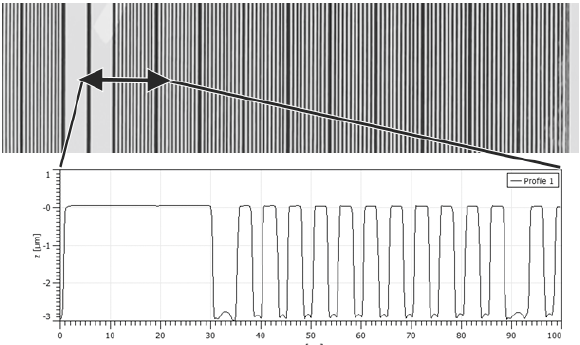
Figure 11. Tip-testing standard TPN 1 with three measurement areas corresponding to the different groove width ranges of a) 0.3 µm to 1.0 µm, b) 1.1 µm to 2.0 µm, and c) 2.1 µm to 3.0 µm.